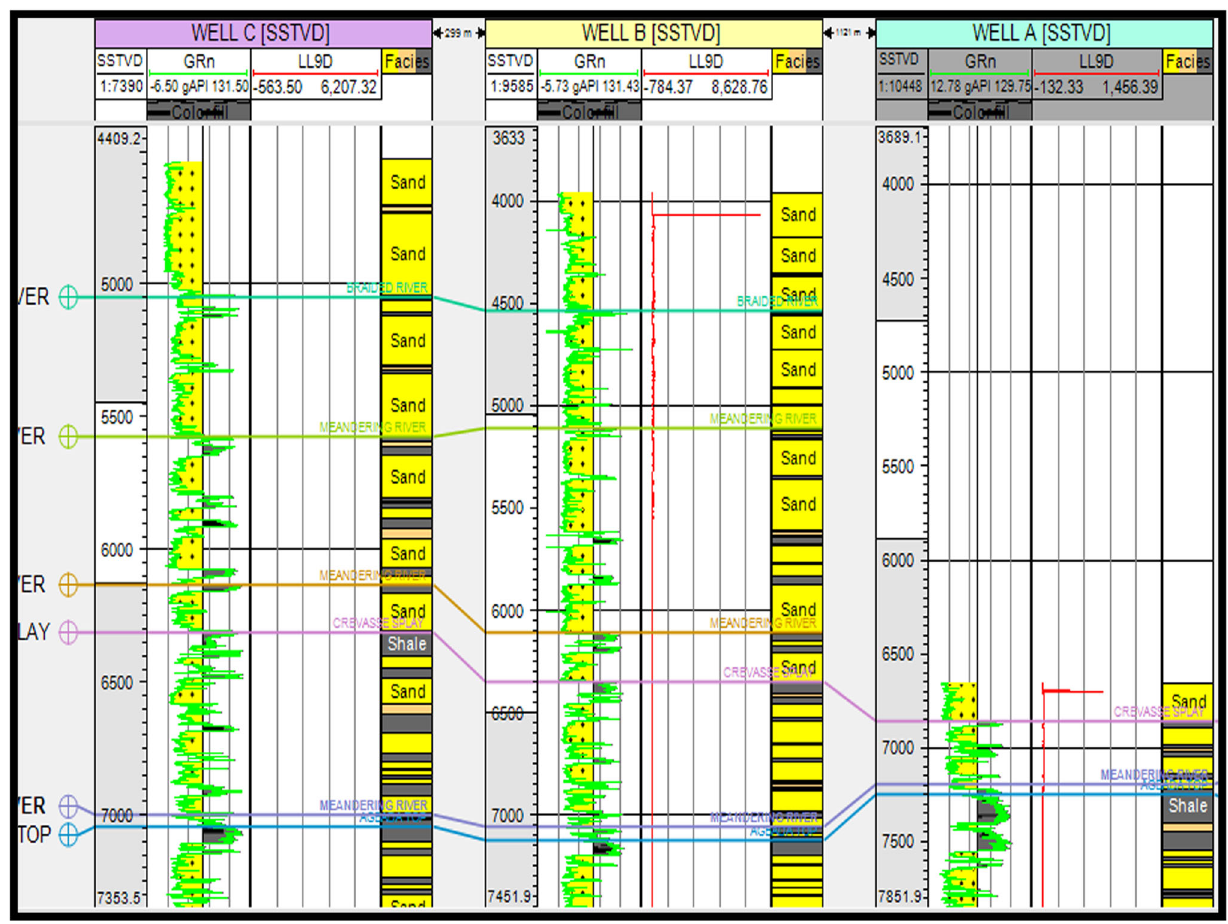
Fig. 4 Subfacies units correlation across the wells within Benin